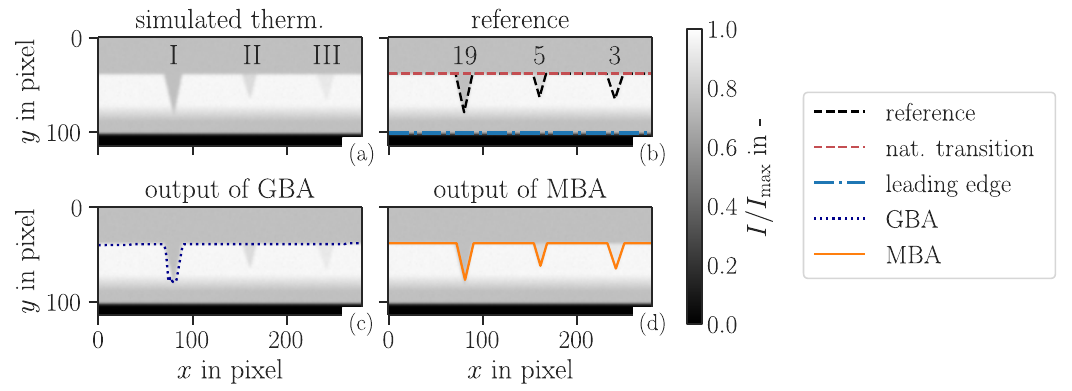
Figure 8. Simulated thermogram with three different turbulence wedges with differing intensities, leading to different CNR values. Both the model-based algorithm as well as the state-of-the-art, gradient-based algorithm were applied to the image. ( a ) shows the simulated thermogram with the turbulence wedges numbered with roman numerals. ( b ) shows the reference transition line as well as the CNR value of the wedges noted above the respective wedge. ( c ) shows the result of applying the gradient-based algorithm (GBA) of Gleichauf et al. [14] to the image and ( d ) shows the result of the application of the model-based algorithm (MBA) on the simulated